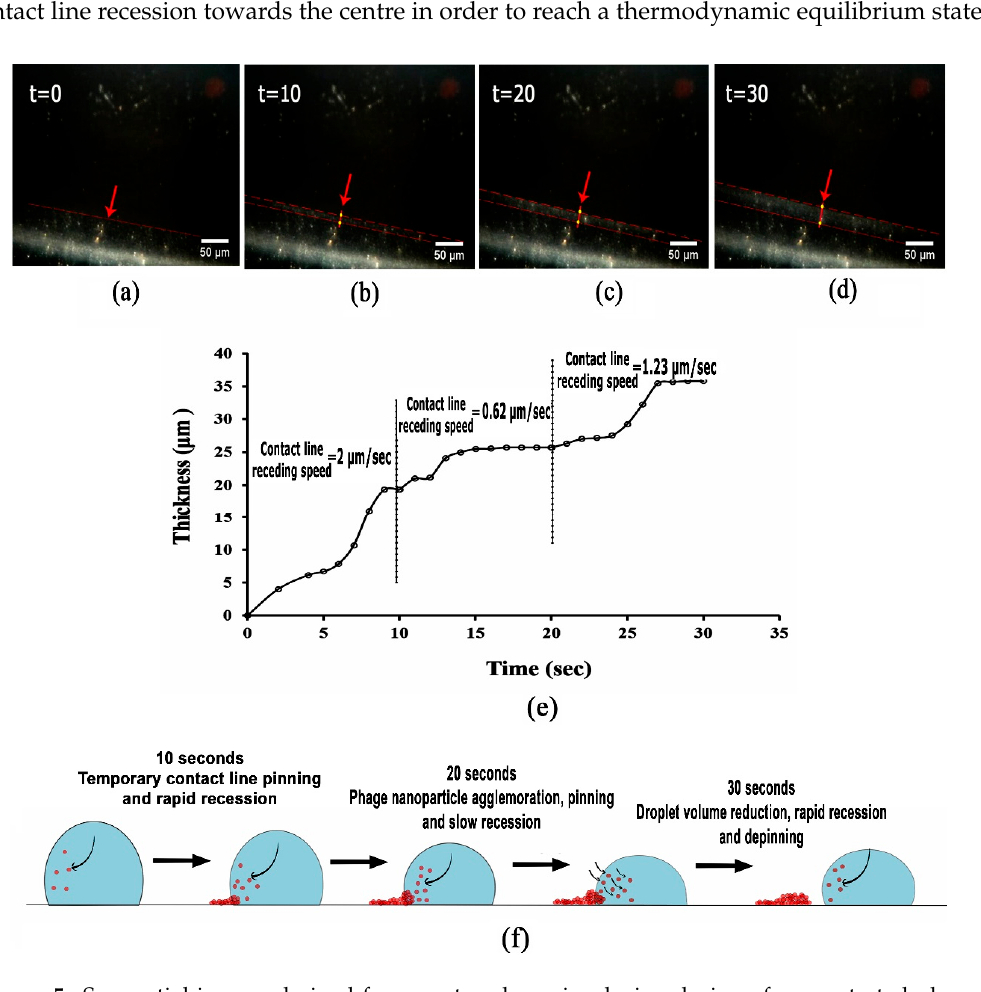
Figure 5. Sequential images derived from captured movies during drying of concentrated phage suspension, showing ( a – d ) concentric ring formation at 36% of drying process, during 30 s in 10 s intervals, using a 20 × objective; ( e ) the contact line receding speed; and ( f ) a schematic diagram of the pinning-depinning process (the black arrows show the direction of phage nanoparticles motion towards the contact line during pinning and towards the centre of droplet during depinning processes).